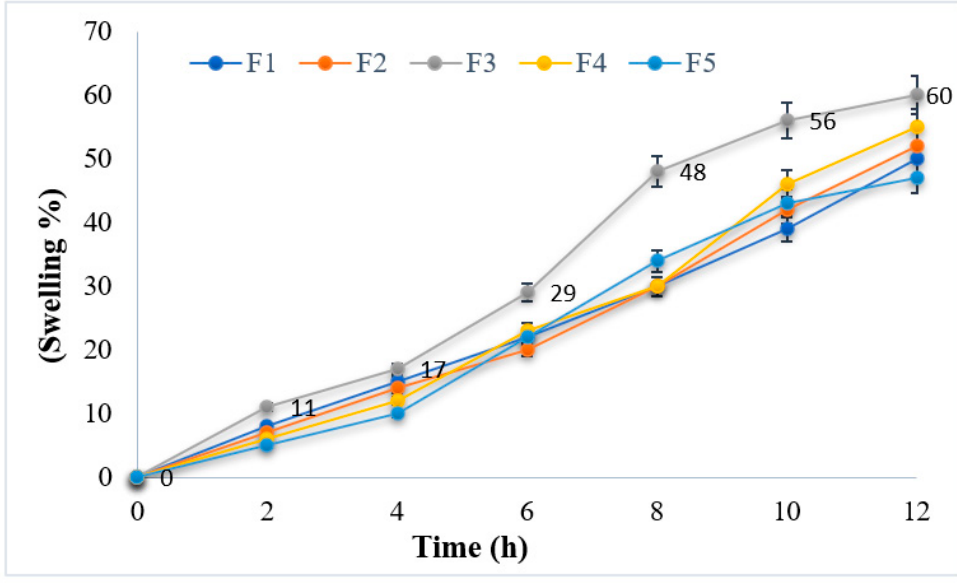
Figure 3. Swelling behavior of esomeprazole-loaded hydrogel formulations (F1–F5).